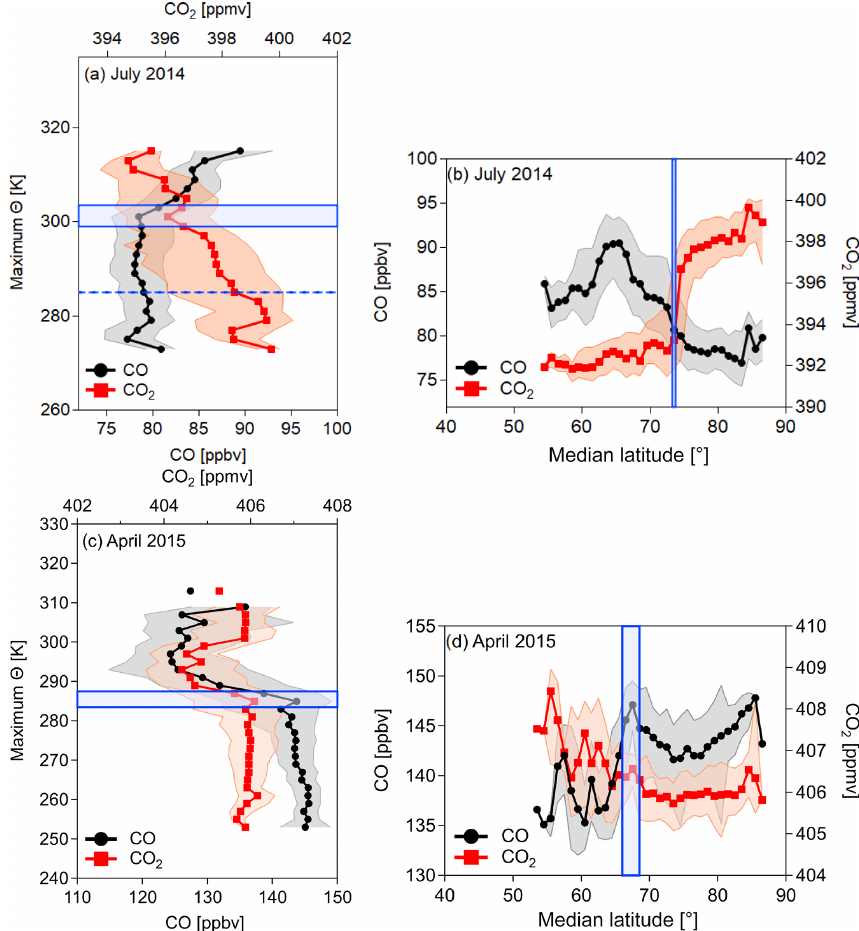
Figure 8. Medians of CO and CO 2 as a function of median trajectory latitude and maximum trajectory potential temperature (for details, see the text). Median values for the vertical profiles were only calculated north of 75 ◦ N for July 2014 (a) and north of 65 ◦ N for April 2015 (c) because latitudinal gradients indicate a dome boundary north of these median latitudes. At lower latitudes transport and mixing homogenize these gradients (see Fig. 7). For both NETCARE campaigns the median horizontal values were derived only below 300K ( b and d ). The blue bar marks the latitude and the potential temperature interval of the strongest change in the tracer mixing ratio, which is interpreted as the transition zone of the polar dome boundary. The shaded area in all figures represents the 1 σ standard